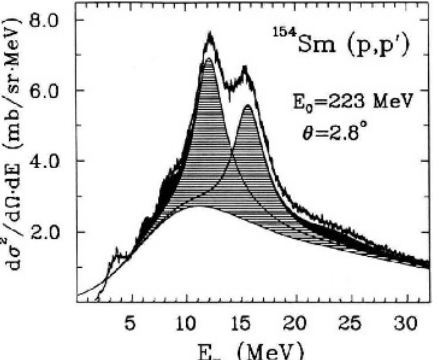
Fig. 2. Double-di ff erential cross section of the 154 Sm( p , p (cid:48) ) re- action measured at θ = 2 . 8 ◦ at TRIUMF [3,4]. A decompo- sition of the spectrum into contributions of the IVGDR (hor- izontally hatched) spin- M 1 resonance (black, low E x ) and the IVGQR (black, high E x ) and a background from quasifree scat- tering (lower smooth line) is shown. From Ref.